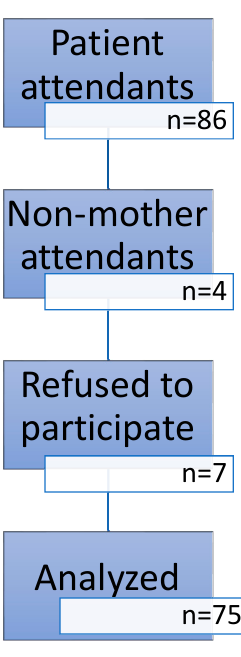
Figure 1. Study flow diagram.